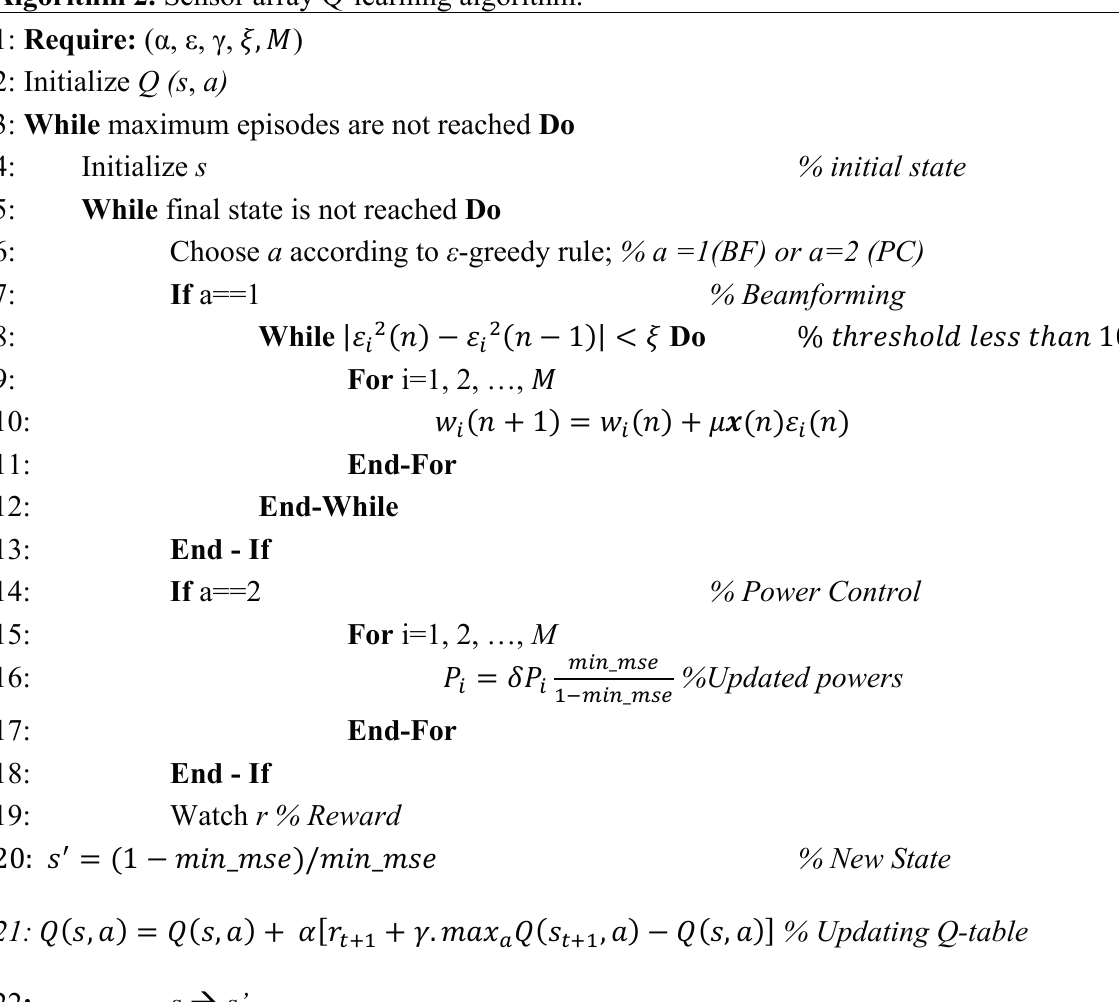
Algorithm 2. Sensor array Q-learning algorithm.